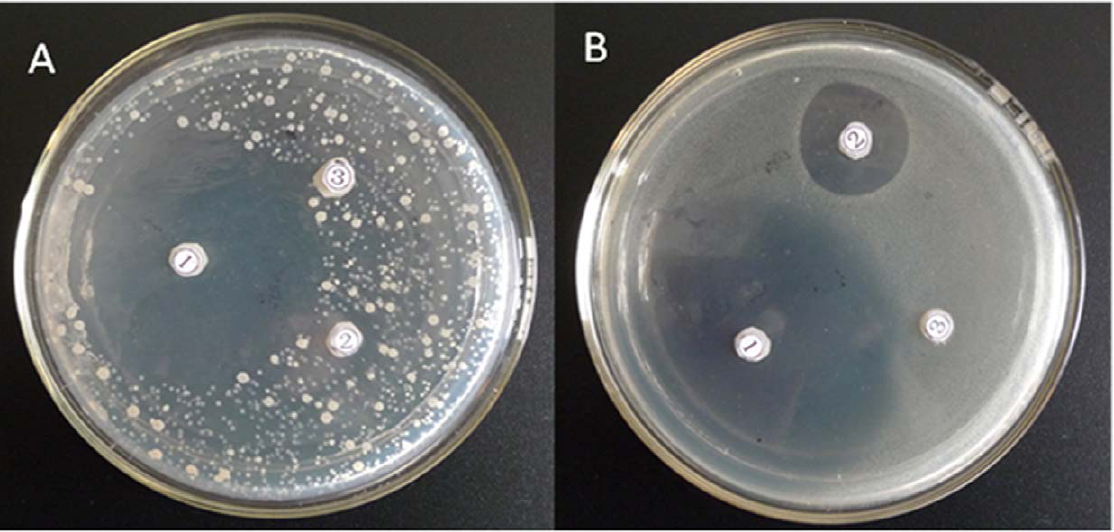
Figure 2. RAcc-royalisin inhibition plate against Gram-positive bacteria. B. subtilis (plate A) and M. flavus (plate B) were treated by RAcc- royalisin a , nisin b and blank control c , respectively.